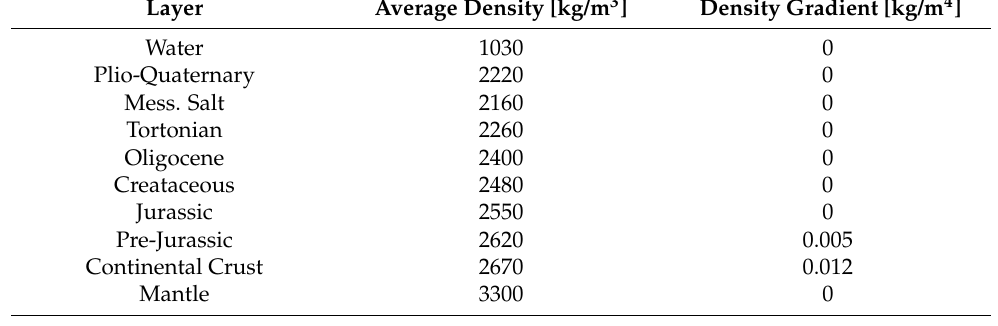
Table 2. Density values used to generate the synthetic model.